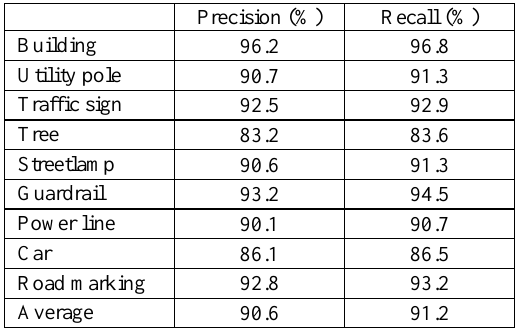
Table 3. Precision and Recall of the proposed method for road features